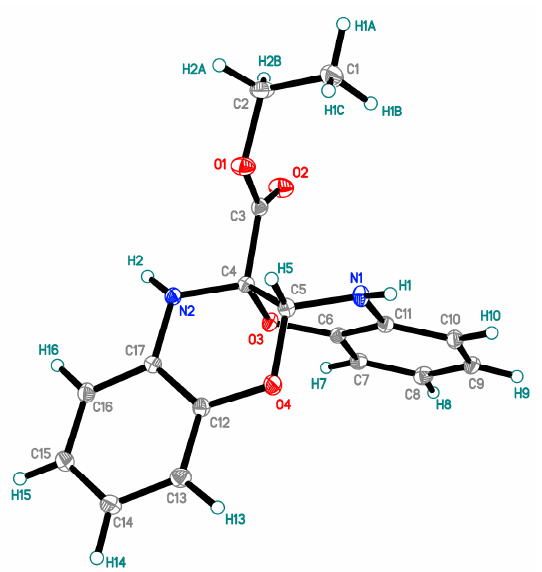
Figure 1. X-ray structure of ethyl 11a,12-dihydrobenzo[ b ]benzo[5,6][1,4]oxazino-[2,3- e ][1,4]oxazine-5a(6 H )-carboxylate 1 . Thermal ellipsoids are at 50% probability. In conclusion, the synthesis of previously unknown ethyl 11a,12-dihydrobenzo[ b ]benzo[5,6][1,4]oxazino[2,3- e ][1,4]oxazine-5a(6 H )-carboxylate 1 from ethyl 2-(hydroxyimino)propanoate and disulfur dichloride was developed. The described experimental